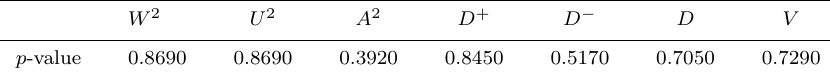
Table 6. Carrol data set: Goodness-of-fit tests. W 2 U 2 p